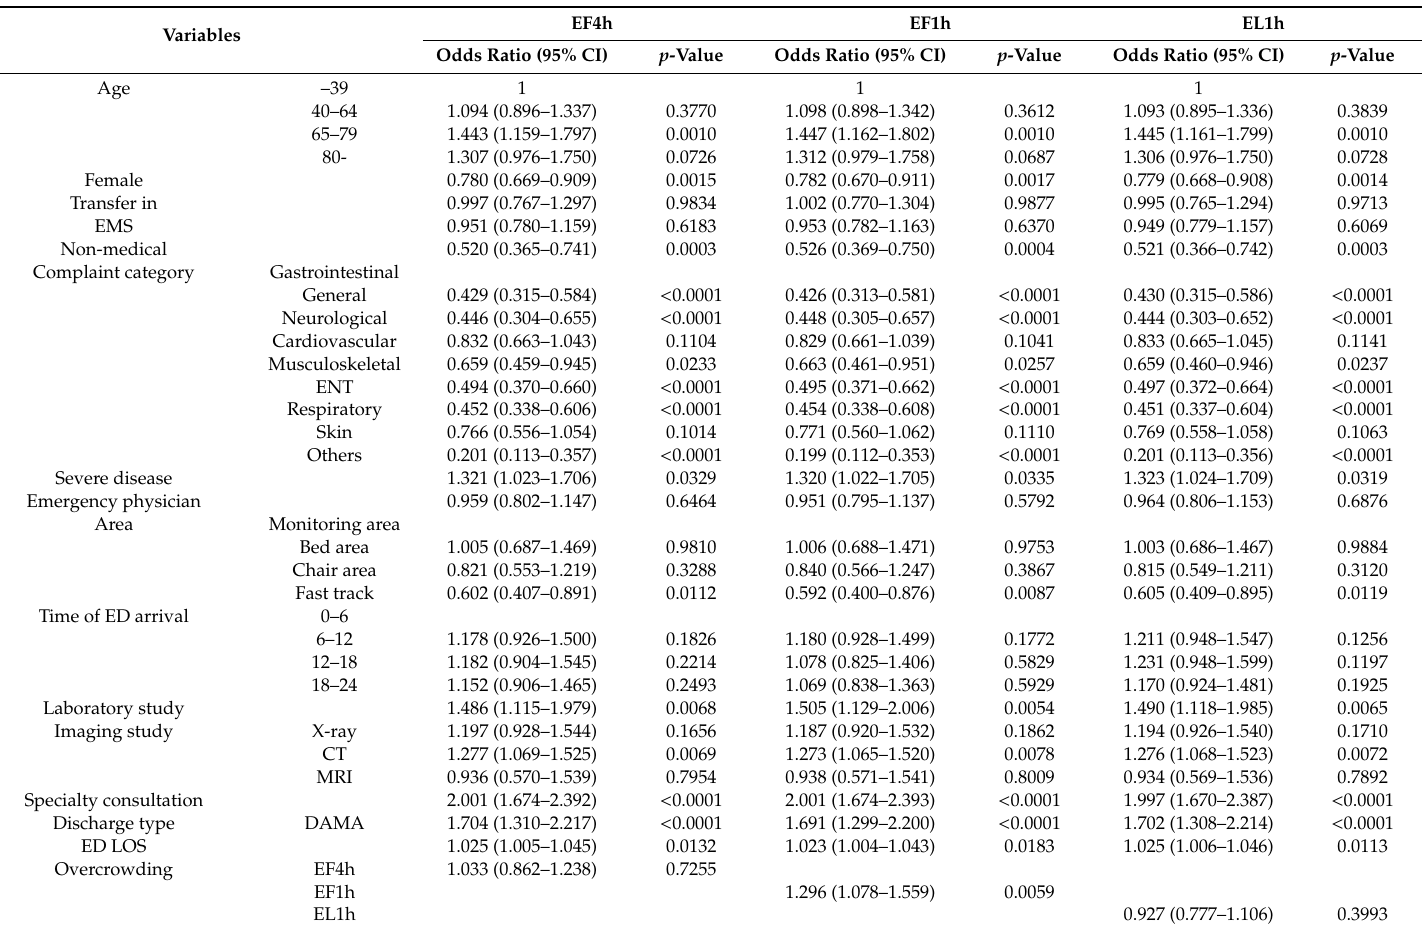
Table A7. Multivariable logistic regression of emergency department overcrowding of the number of evaluating patients for return visit with